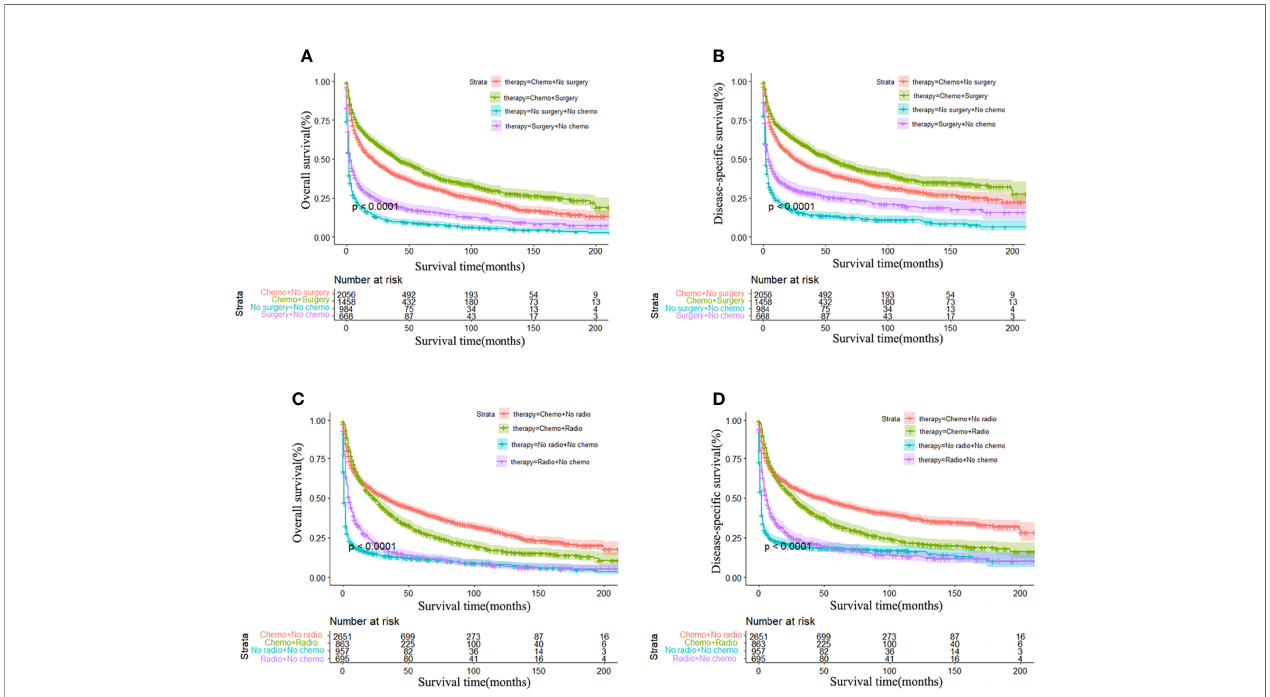
FIGURE 4 | Effect of combination therapy on primary central nervous system lymphoma. Kaplan – Meier survival curves of the combined effect of chemotherapy and surgery: OS (A) and DSS (B) and of chemotherapy and radiotherapy: OS (C) and DSS (D) . Surgery combined with chemotherapy was signi fi cantly associated with better OS and DSS, P < 0.0001. Chemotherapy combined with radiotherapy was associated with better OS and DSS in the early stage of the treatment; however, the long-term OS and DSS were not superior to chemotherapy alone, P <